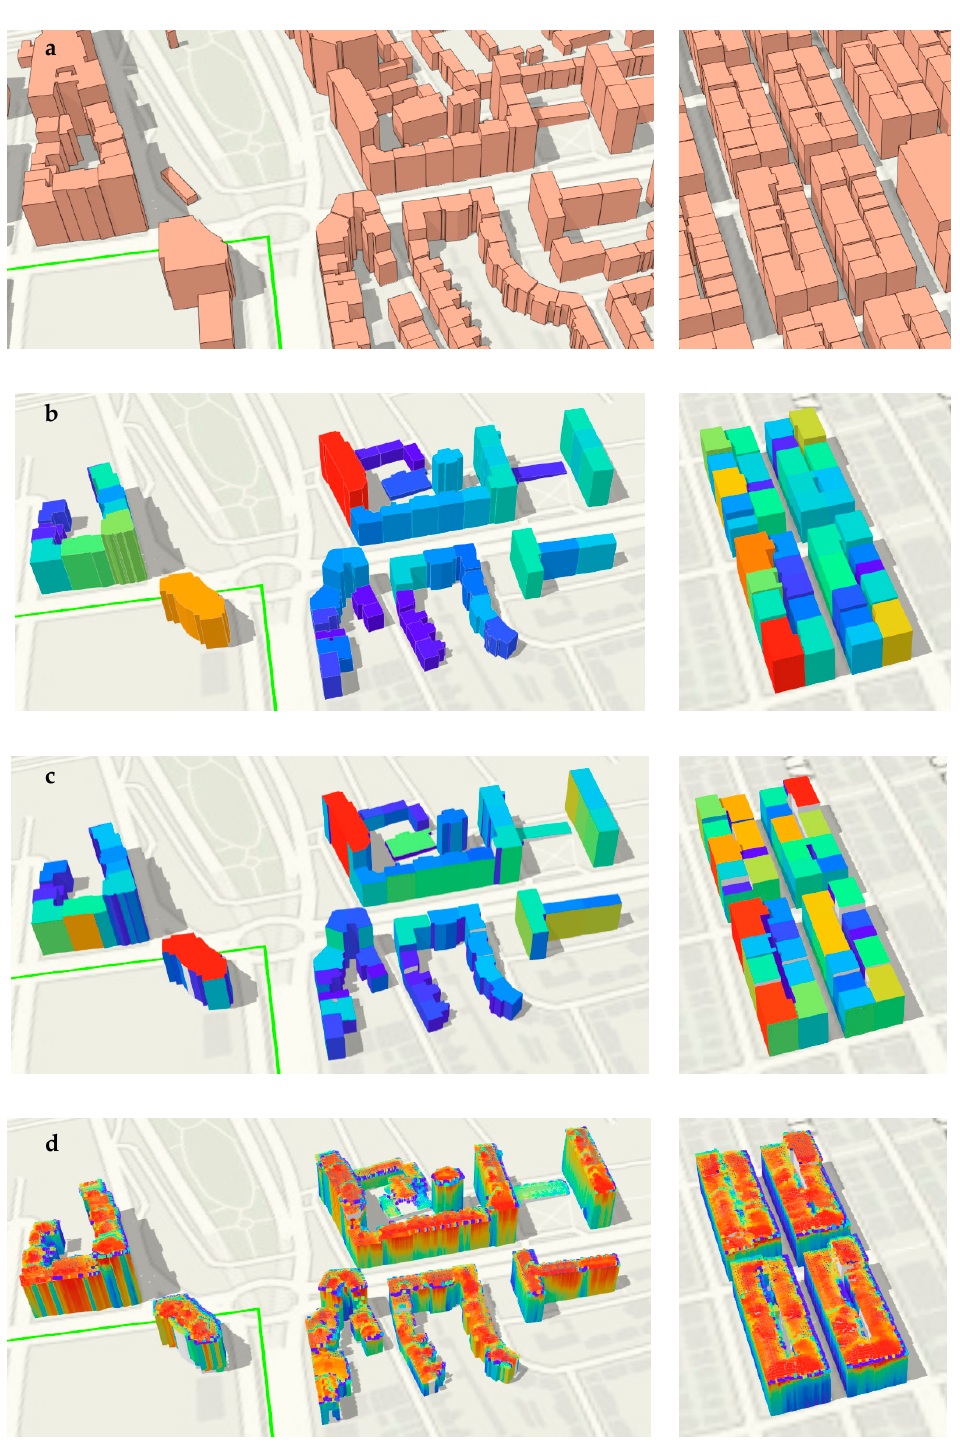
Figure 8. Areas 1 and 2 of the case study. Views showing urban context ( a ) and annual average irradiation per building ( b ), surface ( c ), and element of surface ( d ).